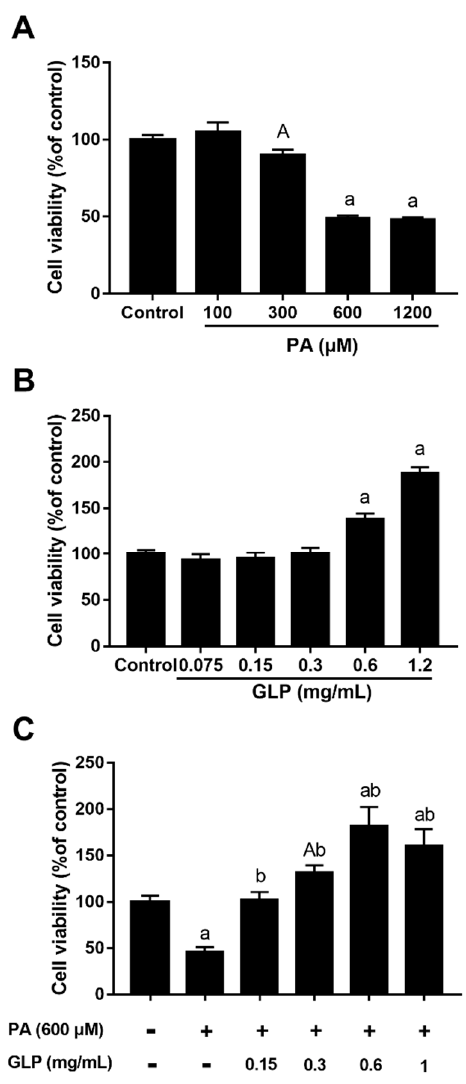
Figure 1. MTT assay determined the effects of palmitic acid (PA) and Ganoderma lucidum polysaccharide (GLP) on IPEC-J2 cell viability. Cells were treated with a 1640 medium containing 10% FBS (control), various concentrations of PA or/and GLP for 24 h. ( A ) Dose-dependent inhibitory effect of PA on IPEC-J2 cell viability. ( B ) The effect of various concentrations GLP (0.075–1.2 mg/mL) on IPEC-J2 cell viability. ( C ) The protective effect of GLP on PA-induced cell viability loss. Values are expressed as percentages of control and are as mean ± SE for three independent experiments ( n = 5). A < 0.05 and a < 0.01 vs. control, b < 0.01 vs. PA alone.